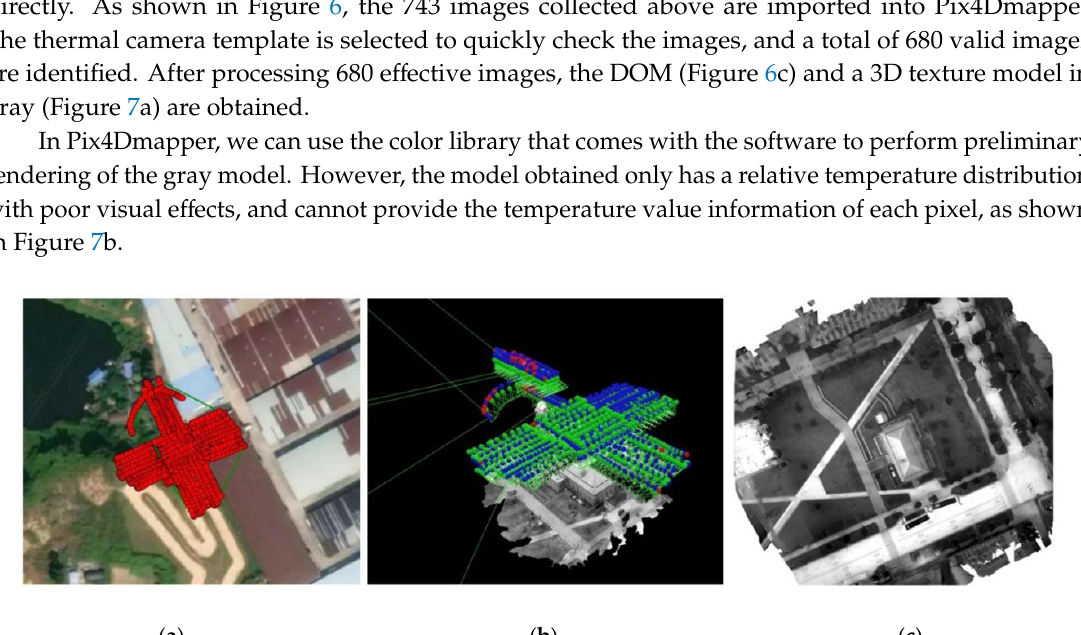
( b ) Figure 7. Images of ( a ) the 3D model in gray, and ( b ) the 3D model in color in Pix4Dmapper. 2.3. Establish the Functional Relationship between Temperature and Gray Value Based on the DOM This section establishes the functional relationship between temperature and gray value based on the obtained DOM, which can provide a theoretical basis for the establishment of a 3D model with temperature attributes. In the 3D gray model generated above, there is only the gray value of the color attribute, and the temperature-related DN value in the original data cannot be read. How to use the gray value to retrieve the DN value of each pixel in the gray model is the key issue to establish a 3D model with